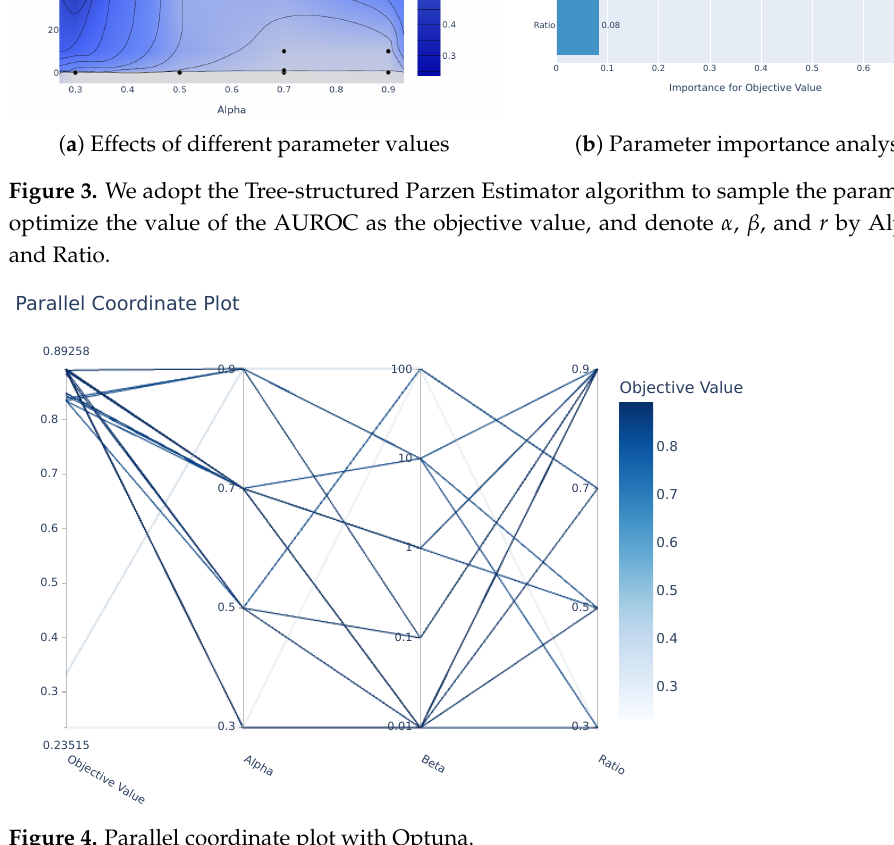
Figure 4. Parallel coordinate plot with